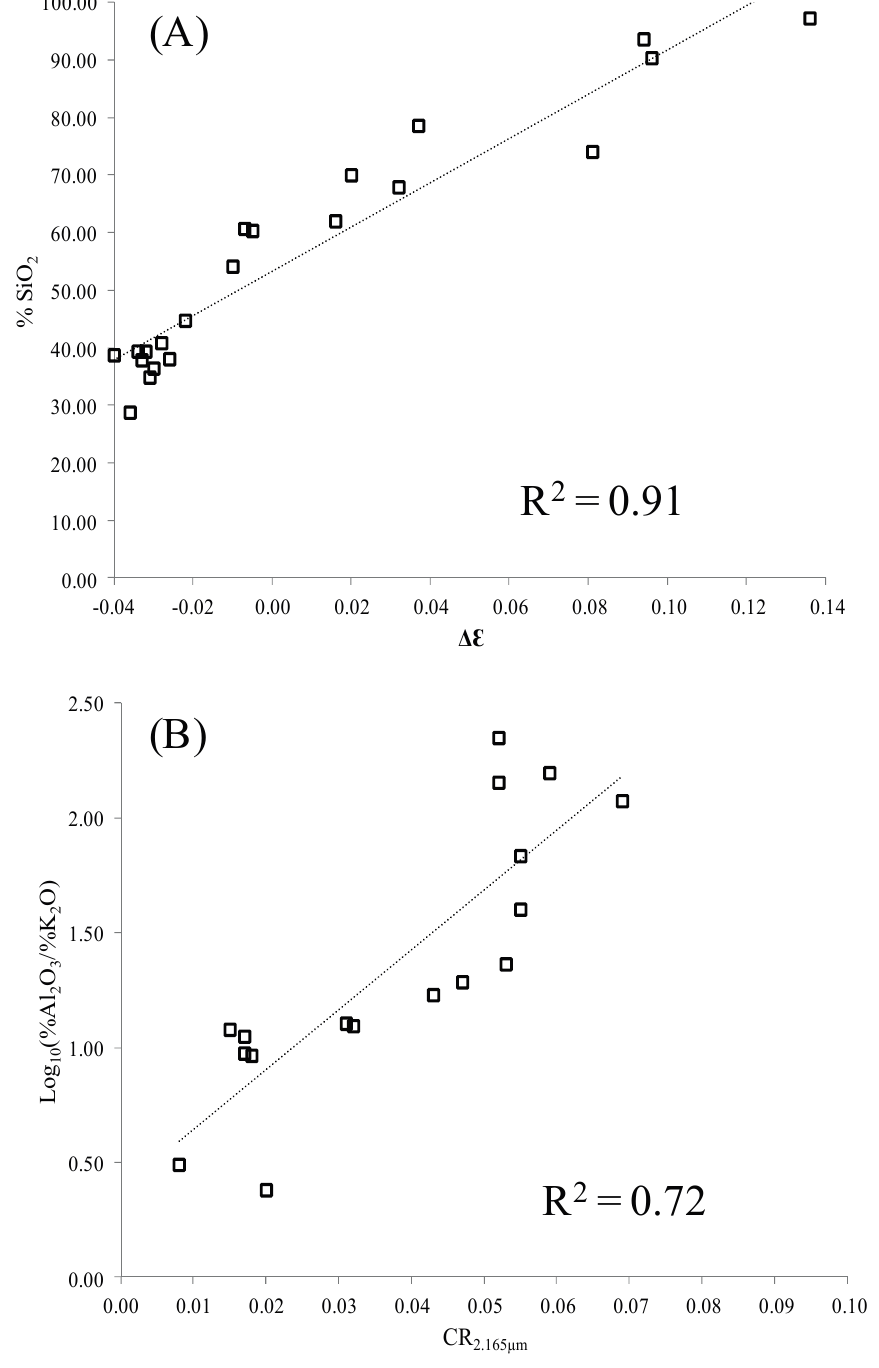
Figure 14. ( A ) Correlation between the measured %SiO values; ( B ) Correlation between the measured Log calculated CR 2.165µm